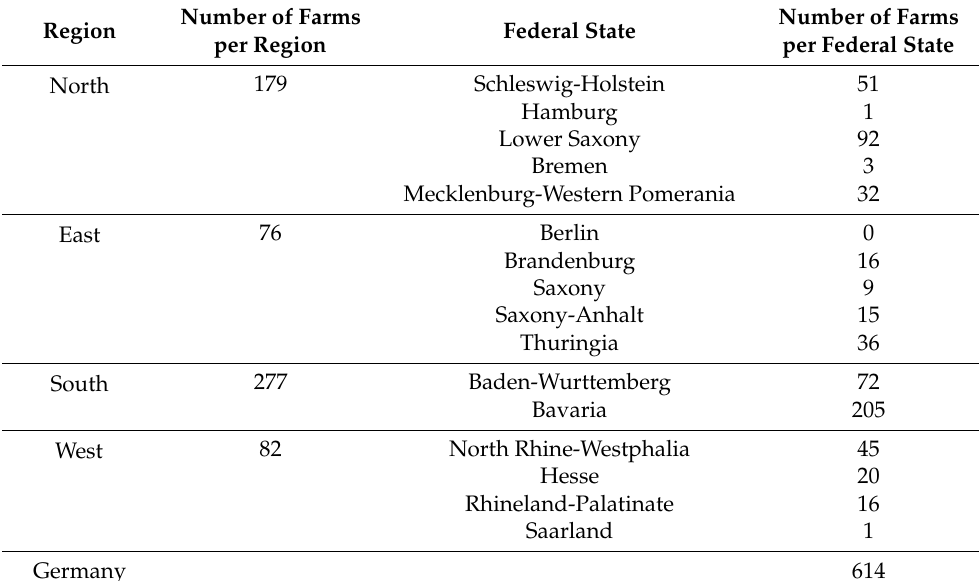
Table 1. Number of sampled farms per German region and federal